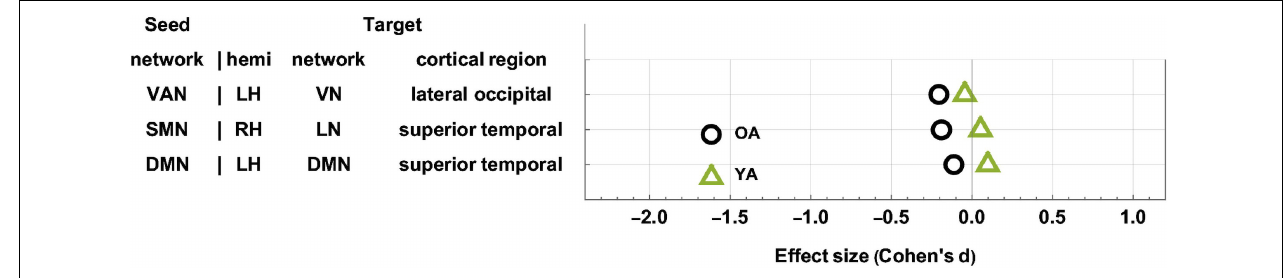
FIGURE 4 | Age-related differences in FC change after TBI. OAs exhibit FC decreases across all statistically significant target clusters, whereas YAs exhibit relatively fewer significant changes across the ∼ 6-month follow-up period. The horizontal axis encodes effect size (Cohen’s d ), and seed-target cluster pairs are listed in ascending order according to males’ effect size d . FC, functional correlation; OA, older adult; TBI, traumatic brain injury; YA, young adult.